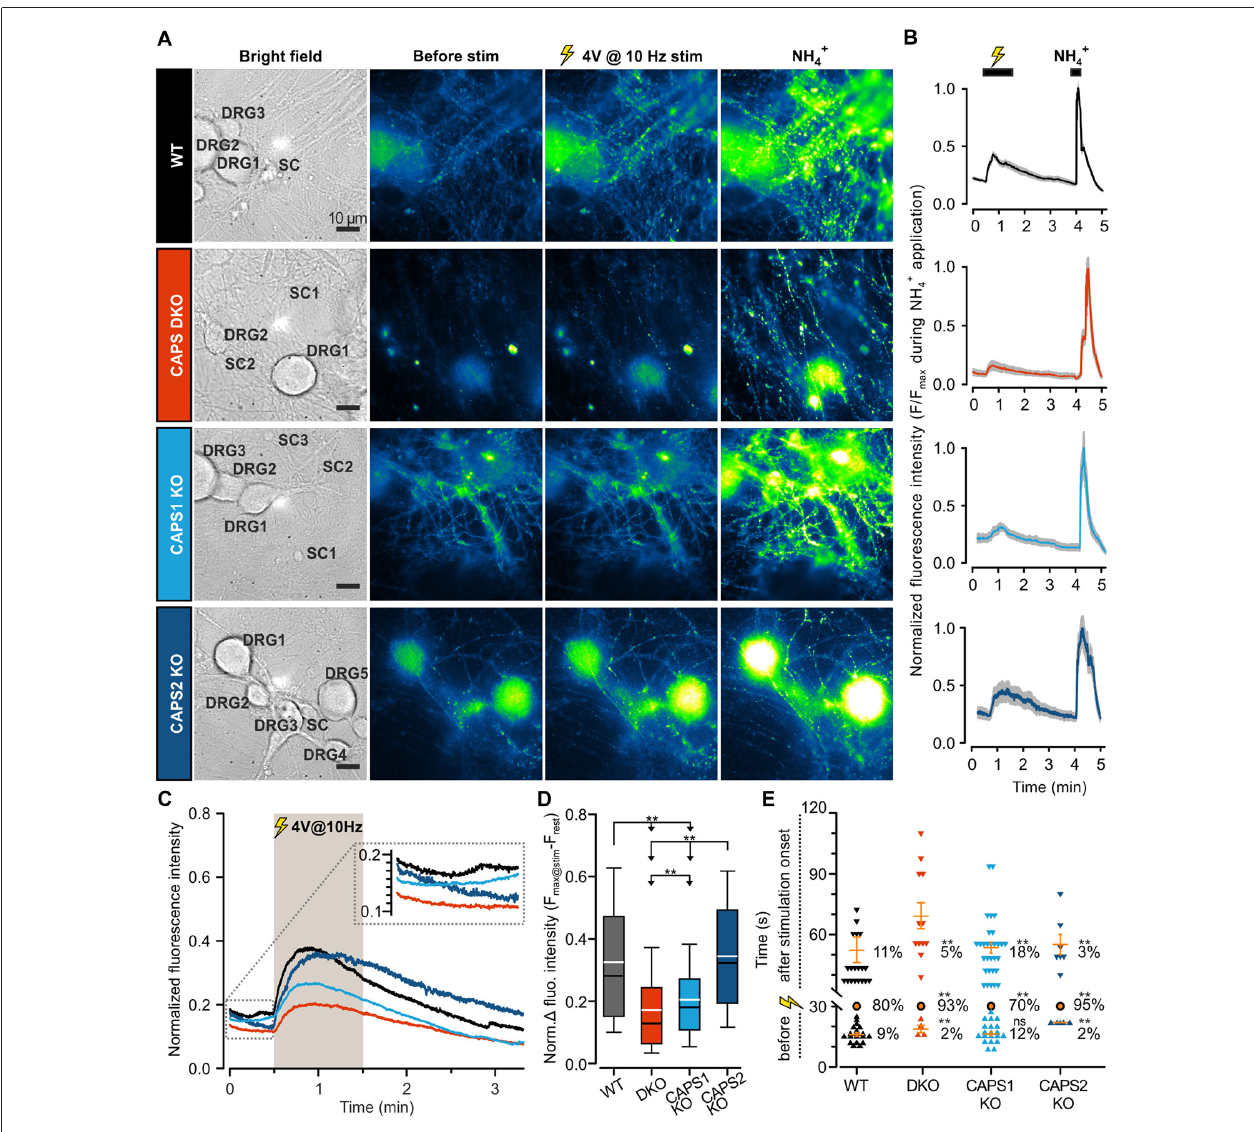
FIGURE 6 | CAPS1 mediates synaptic transmission between DRG and SC neurons. Embryonic WT, CAPS DKO, CAPS1 KO or CAPS2 KO DRG neurons were transfected with Synaptophysin-pHluorin (SypHy) and co-cultured with WT SC neurons. Synaptic transmission was measured after 8 DIV. (A) Co-cultured neurons are shown from left to right in bright field and in epifluorescence to visualize the SypHy signal before and during 10 Hz field electrode stimulation, and upon NH 4 Cl application. For the purpose of normalization, 40 mM NH 4 Cl was used to deprotonate the lumina of synaptic vesicles (SVs), thereby allowing visualization of the entire SV pool. The neuron types are indicated in bright field images. Scale bar = 10 µ m. (B) Time course of normalized average SypHy fluorescence intensity at synapses of the recordings displayed on the same row in (A) . The fluorescence intensity of each synapse was normalized to their individual maximal intensity measured during NH 4 Cl application. The SEM range is indicated by the shaded gray area. (C) The normalized average SypHy signal at synapses in response to electrical stimulation for WT neurons (black), CAPS DKO neurons (red), CAPS1 KO neurons (light blue) and CAPS2 KO neurons (navy blue) indicate that deletion of CAPS1 alone was sufficient to severely reduce synaptic transmission. The shaded gray area corresponds to the stimulation period. The SEMs were too small to be displayed. The inset corresponds to the fluorescence intensity fluctuation prior to stimulation. (D) Box plot of the maximum normalized fluorescence intensity increase in SypHy elicited by 10 Hz electrical stimulation. CAPS DKO as well as CAPS1 KO strongly reduced SV exocytosis while CAPS2 deletion had no effect. The white and black lines in the box correspond to the average and median fluorescence increase, respectively. Outliers are not displayed, in order to ease legibility. Significance was tested with ANOVA on rank and Dunn’s post significance test. (E) Quantification of the time point of synaptic response suggests that the presence of CAPS2 causes non-synchronized synaptic activity. The time of synaptic activity was divided into three groups. Each synapse responding either before stimulation or with a delay is represented as an individual symbol. Orange dashes are the average time points of response ± SEM for these two groups. All synapses responding within 1 s of stimulus onset are represented as a single orange circle. The percentage of synapses belonging to each group is provided to the right of response time. These percentages were tested with ANOVA on ranks and Dunn’s post significance test comparing all values to WT controls. Experiments were performed on a minimum of three independent cultures for every genotype. WT n DRG neurons = 32, n synapses = 209; CAPS DKO n DRG neurons = 35, n synapses = 252; CAPS1 KO n DRG neurons = 38, n synapses = 270; and CAPS2 KO n DRG neurons = 28, n synapses = 155. ns = not significant ( p > 0.05), ∗∗ p < 0.01.